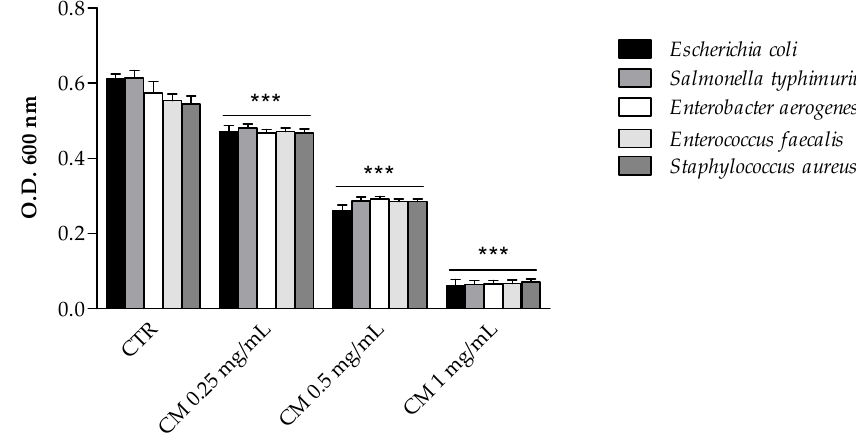
Figure 3. Antimicrobial activity (final O.D.) of C. maritimum L. extract (CM) (0.25, 0.50 and 1.00 mg/mL) against Gram negative bacteria ( Escherichia coli ATCC 25922, Salmonella enterica ser. typhimurium ATCC 14028, and Enterobacter aerogenes ATCC 13048 ) and Gram positive bacteria ( Enterococcus faecalis ATCC 29212 and Staphylococcus aureus ATCC 25923). Results are reported as mean values ± standard deviation ( n = 3). *** Highly significant difference from negative control (CTR) ( p ≤ 0.001).